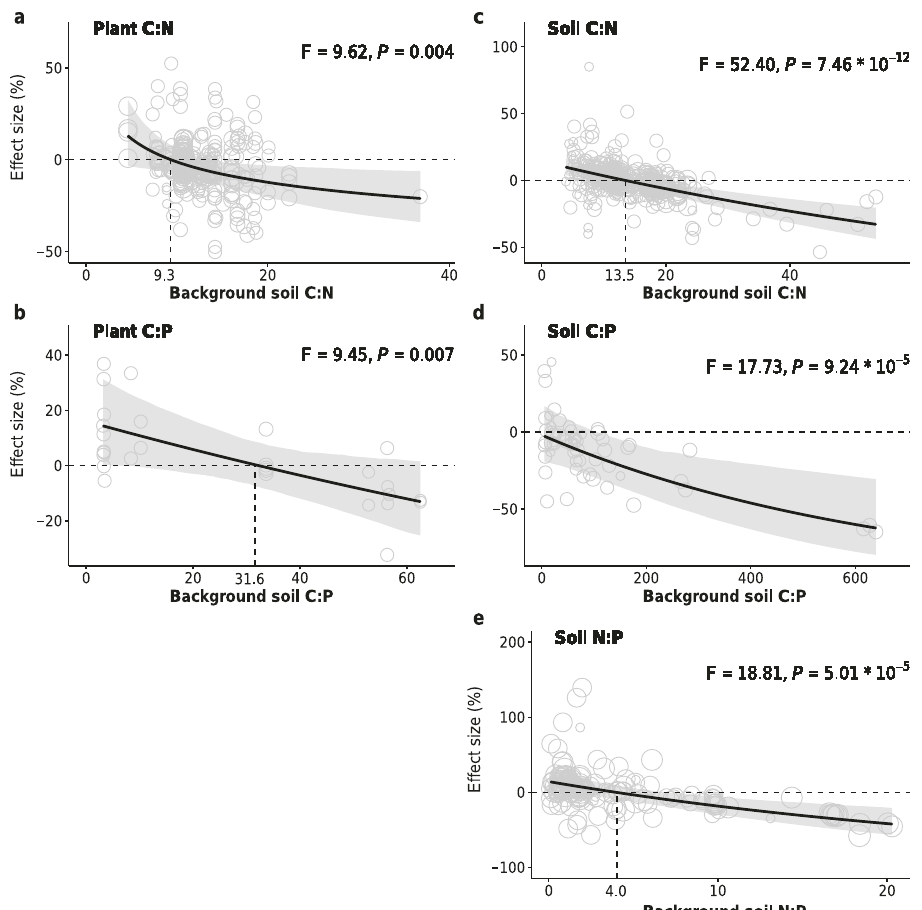
Fig. 4 Comparison of C:N, C:P, and N:P ratios of plant and soil in species mixtures versus monocultures in relation to the background soil nutrient status. a Plant C:N ratio; b plant C:P ratio; c soil C:N ratio; d soil C:P ratio; e soil N:P ratio. The effects are quanti fi ed as the percent changes in mixtures compared to the corresponding mean value of constituent monocultures. Points represent the values predicted by partial regressions for each explanatory variable, with their sizes representing the relative weights of corresponding observations. Slope estimates are partial dependence, derived from the full model (see “ Methods ” section). Black lines represent the average responses with their bootstrapped 95% con fi dence intervals shaded in